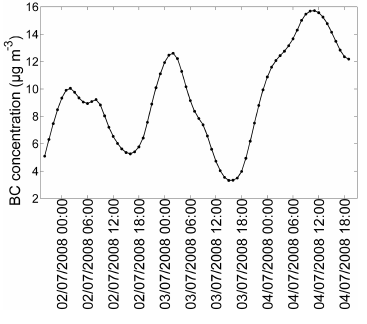
Figure 4. Hourly variation of simulated ground BC concentration over the Beijing